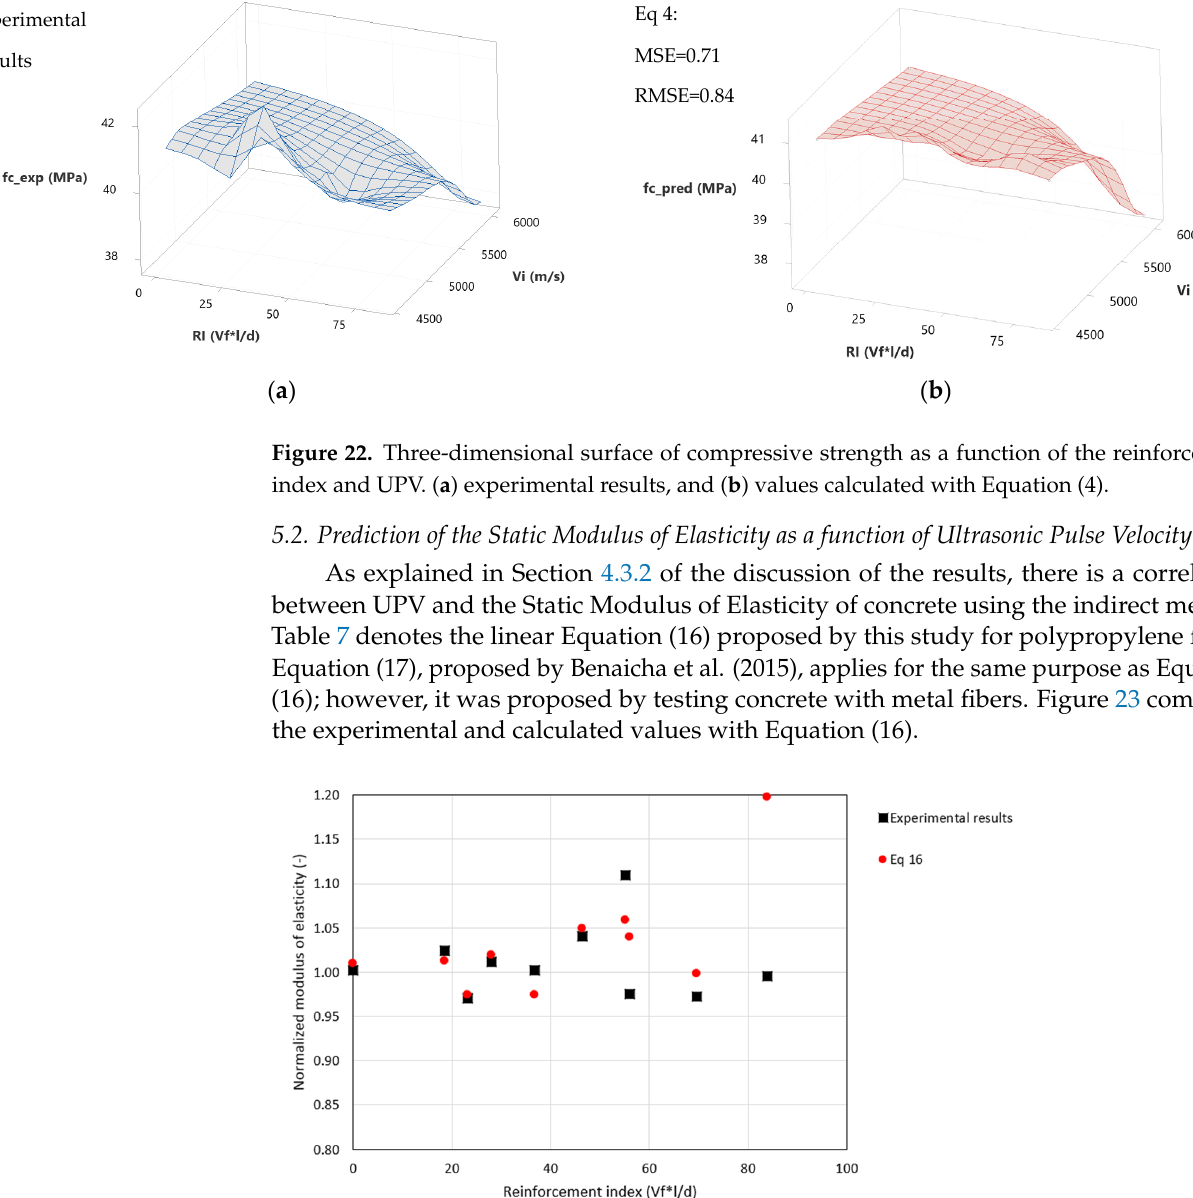
Figure 21. Histogram of the RMSE value with Pareto diagram for each equation.